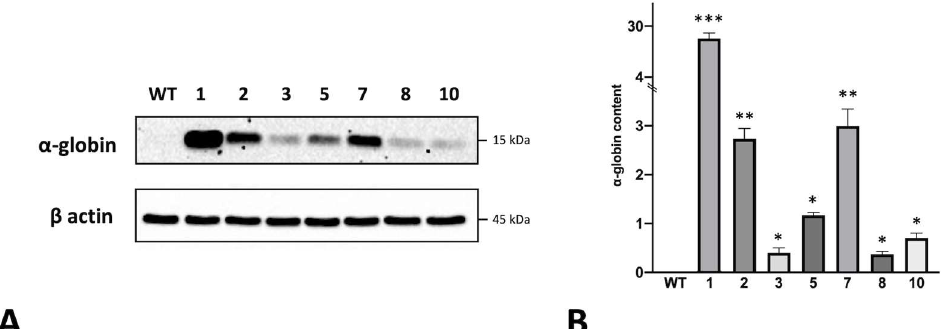
Figure 3. Representative Western blot experiment showing α-globin protein content in cellular lysates of K562 wild-type cells and obtained clones ( A ) and relative densitometry data set ( B ); data were normalized on β-actin (mean ± SD; N = 3). p < 0.05 (*), p < 0.01 (**), p < 0.001 (***).